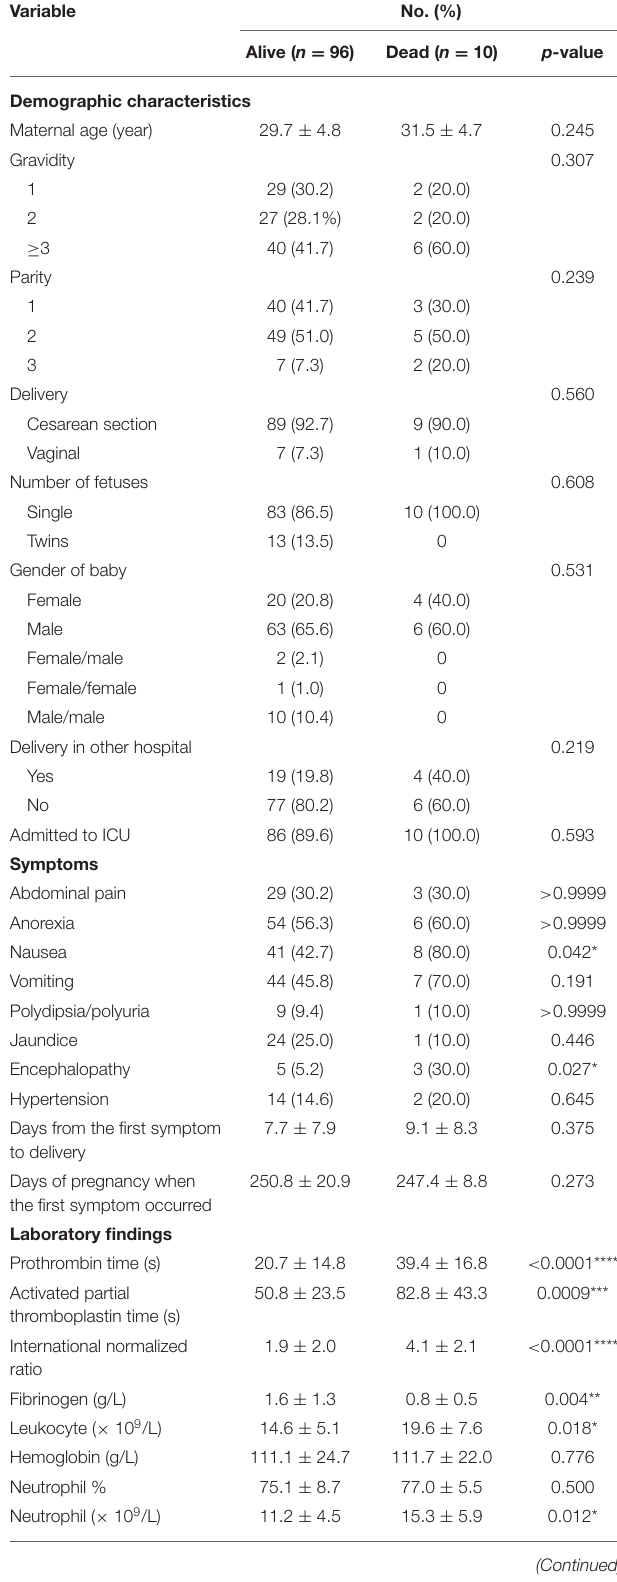
TABLE 5 | Comparison of demographic, clinical, and laboratory characteristics between maternal survivors and